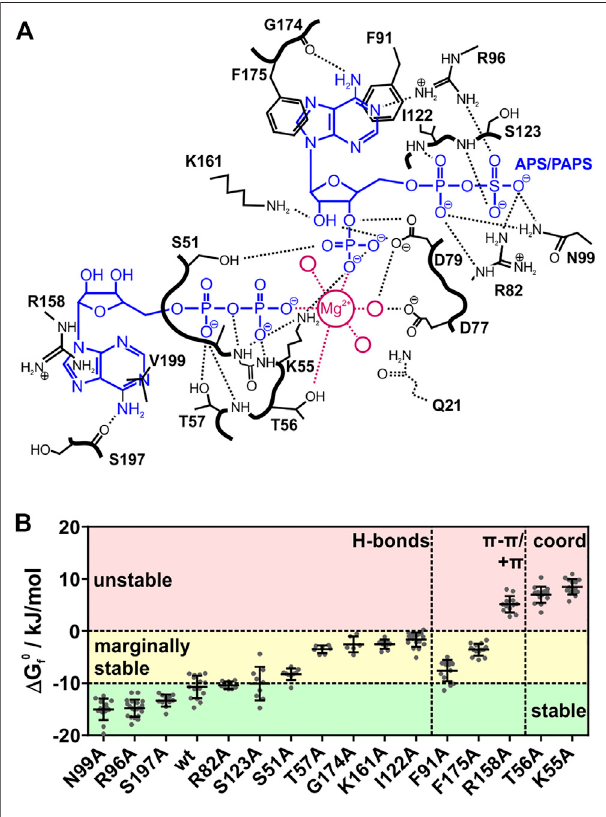
FIGURE 2 | Interactions and stability of APSK37 point-mutants. (A) ContactmapoftheADP/ATPandAPS/PAPSbindingsiteofthePAPSS1APS kinase domain adapted from Sekulic et al. (PDB: 2PEZ). Magenta colored circles represent water molecules coordinating the magnesium cation. Bold black lines represent the peptide backbone. Q21 was deleted in APSK37 (B) Standardfreeenergyoffoldingat37 ° C( Δ G f0 )forin-cellmeasured APSK37 binding site mutants. Mutations with a Δ G f0 lower − 10 kJ/mol are referred to as stable. Mutations showing Δ G f0 of − 10 kJ/mol to 0 kJ/mol are referred to as marginally stable. Mutations showing Δ G f0 larger 0 kJ/mol are referred toas unstable. Data points depict single cells measured. Bars refer to mean ±